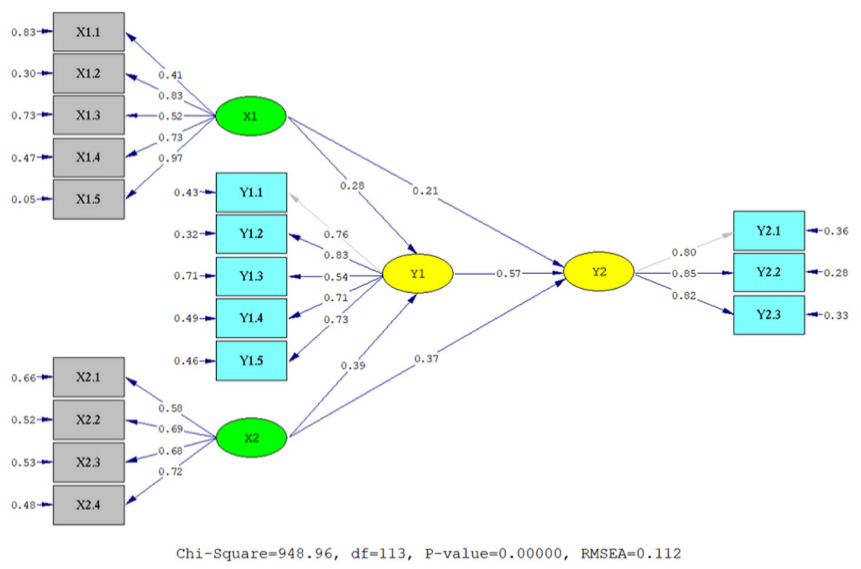
Figure 1. Standardized structural model. Note: X 1 = EI, X 2 = AQ, Y 1 = OCB, Y 2 = Teachers’ professional competence.